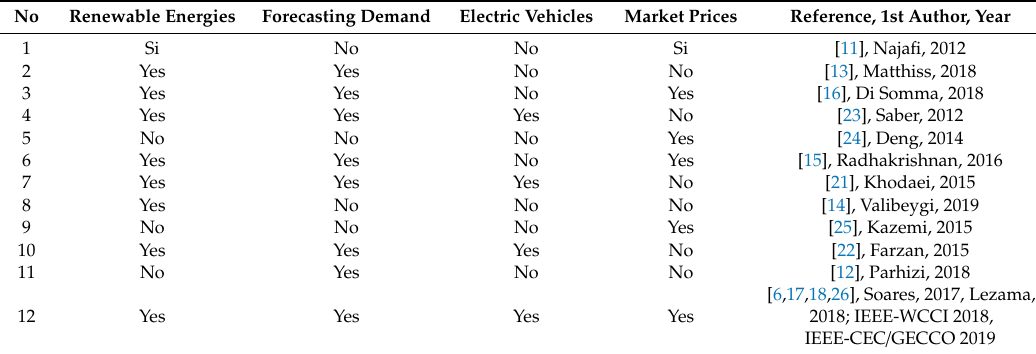
Table 1. Sources of